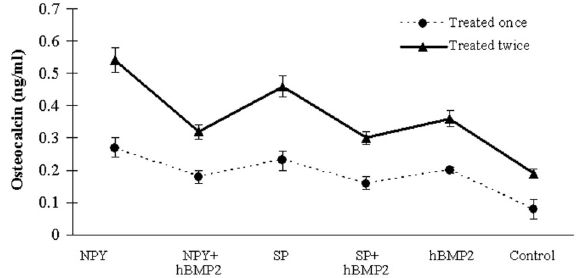
Figure 5. Osteocalcin assay. The graph shows the osteocalcin of the osteoblasts treated once or twice with 0.1 m g/mL neuropep- tide Y (NPY), substance P (SP) and human bone morphogenetic protein 2 (hBMP2) alone, as well as their combined applications. The osteoblasts exposed to 0.1 m g/mL NPY had the highest level of osteocalcin. The osteoblasts treated twice with the neuropep- tides or hBMP2 displayed higher osteocalcin than those treated only once. Furthermore, the osteocalcin levels of cells exposed to 0.1 m g/mL neuropeptides alone were also significantly higher than those of the osteoblasts exposed to neuropeptides combined with hBMP2 (P , 0.05, ANOVA).